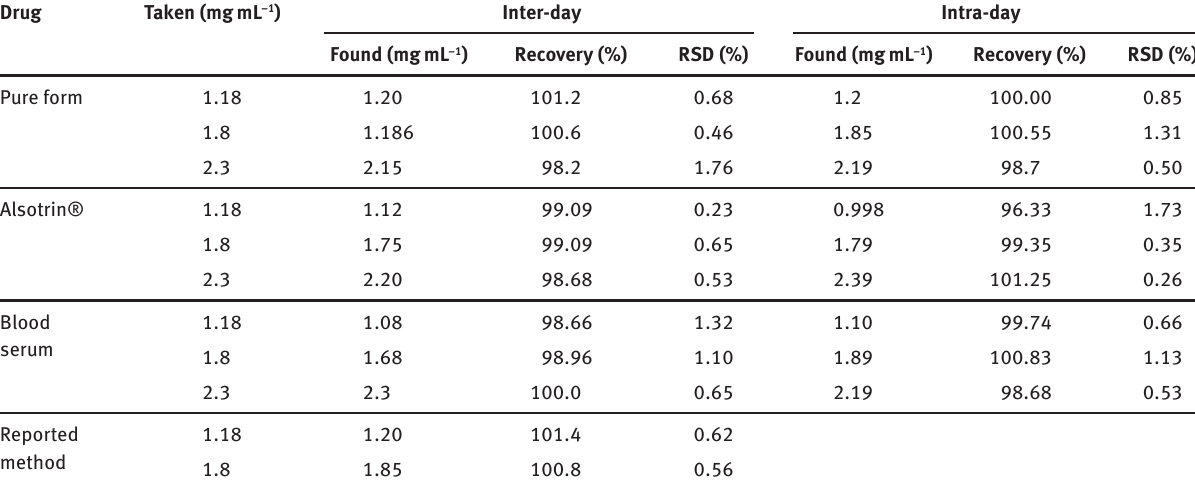
Table 5: Evaluation of the proposed method in pure type ALV, Alsotrin® capsule, and blood serum intra- and inter-day consistency and accuracy of the proposed method